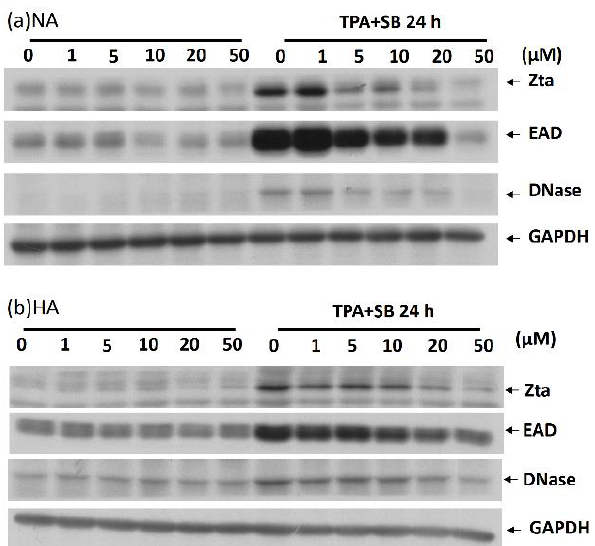
Figure 2. Kaempferol treatment inhibits EBV reactivation in NPC cell lines. ( a ) NA and ( b ) HA cell lines were prepared for the detection of the effects of kaempferol treatment on EBV reactivation. For detecting the enhancement of EBV reactivation, the cells were treated with kaempferol alone for 25 hr (left panels). For detecting the inhibition of EBV reactivation, the cells were pre-treated with kaempferol for 1 hr and then treated with TPA + SB for a further 24 h. All samples were collected for Western blotting analysis with antibodies against EBV lytic proteins Zta, EAD and DNase, and GAPDH was served as a loading control.